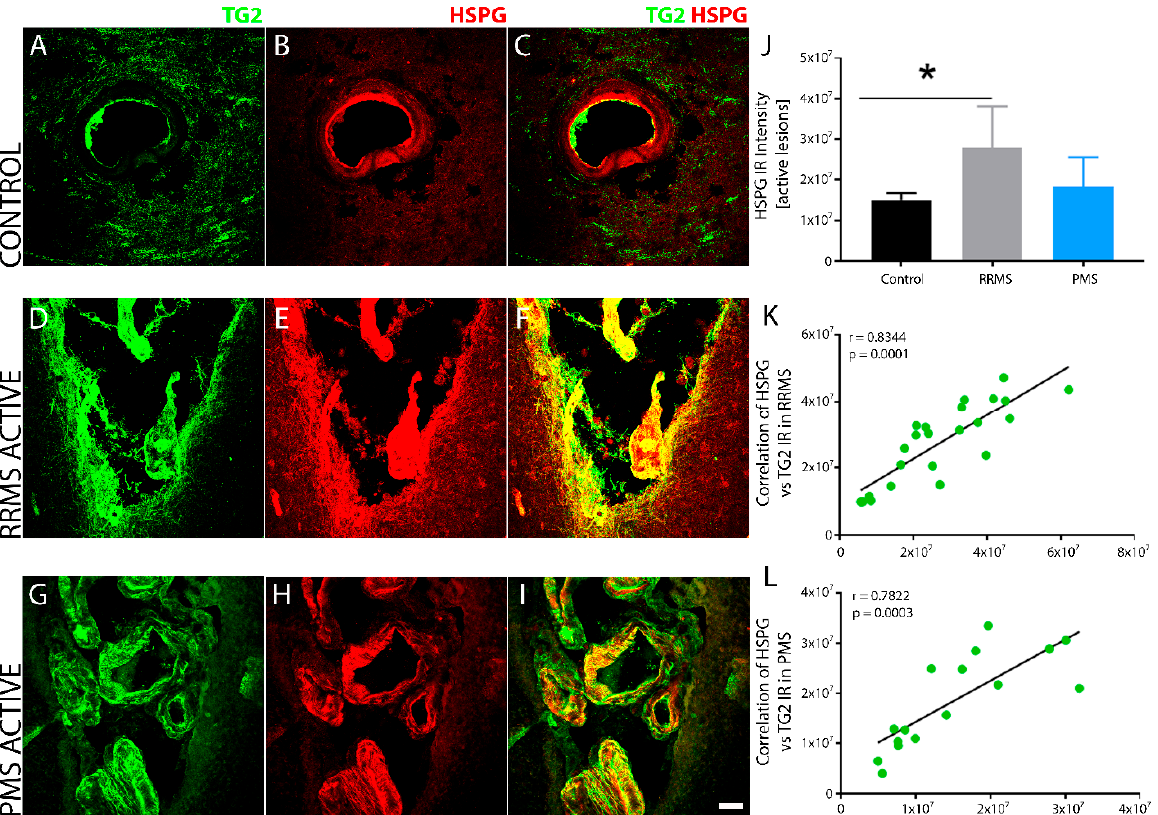
Figure 8 . TG2 and HSPG immunoreactivity overlap in sclerotic lesions after RRMS. In contrast to non ‐ MS control brain tissue, which exhibited lower expression levels of TG2 and HSPG in the basal lamina of the blood vessels ( A – C ), sclerotic lesions after RRMS ( D – F ) show pronounced and overlapping reactivity of HSPG and TG2 immunofluorescence both in the center and the edge of the sclerotic lesions. The extent of HSPG expression in lesions after PMS was not as robustly increased ( G – I ) compared to the RRMS lesions and was mostly limited to the lesion center. Quantitative assessment of HSPG immunoreactivity from active lesions of the two forms of MS indicated significant upregulation in the levels of HSPG only after RRMS and not PMS compared to non ‐ MS controls ( J ). Scale bar = 30 μ m. Data were quantified and expressed as value of the mean plus the standard deviation (SD). Statistical significance indicated a * p < 0.05, determined using a 1 ‐ way analysis of variance and post hoc Tukey test. The extent of HSPG expression was proportional to the lesion associated TG2 levels and showed a significant positive correlation to the intensity of TG2 IR in sclerotic lesions after both RRMS ( L ) and CPMS ( K ). The correlation between the levels of HSPG and TG2 in the lesions from all the patients in each of the two forms of MS is shown in ( K , L ). The p ‐ value determined by linear regression and Pearson correlation coefficient (r) is indicated for each of the analyses.